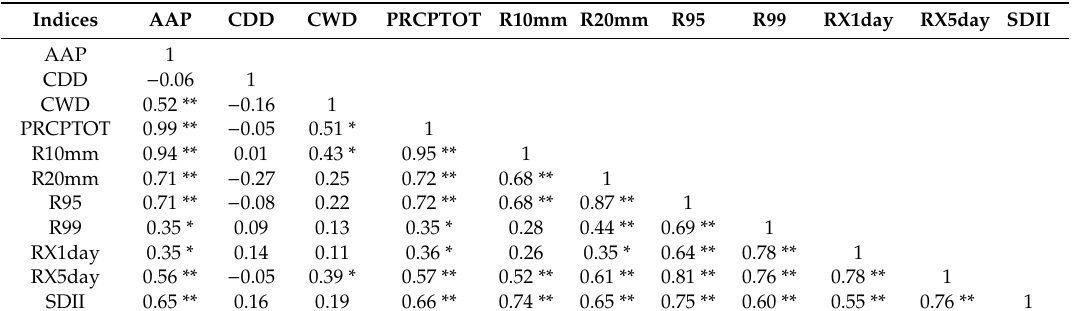
Table 3. Correlation coe ffi cients between annual average precipitation (AAP) and the extreme precipitation indices in the Tibetan Plateau.